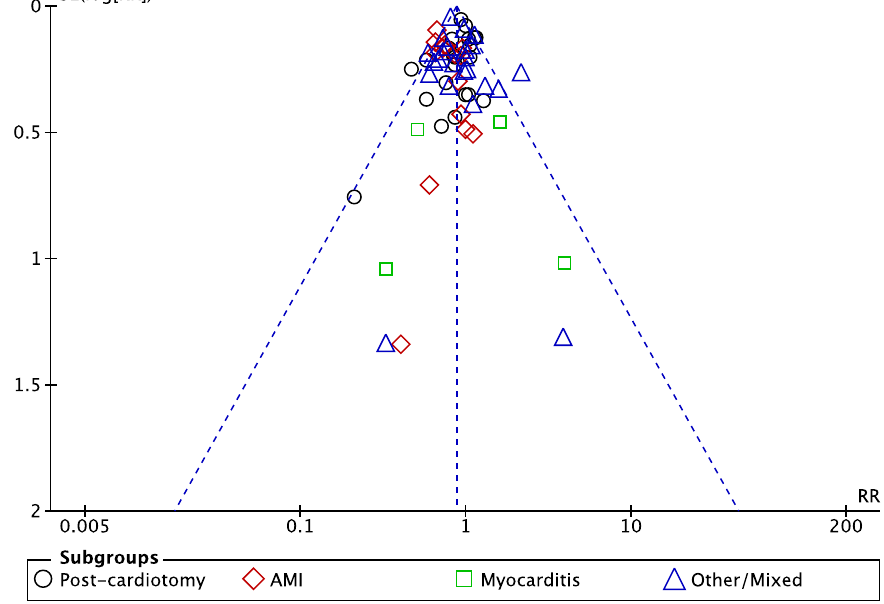
Figure 2. Publication bias analysis (SE: standard